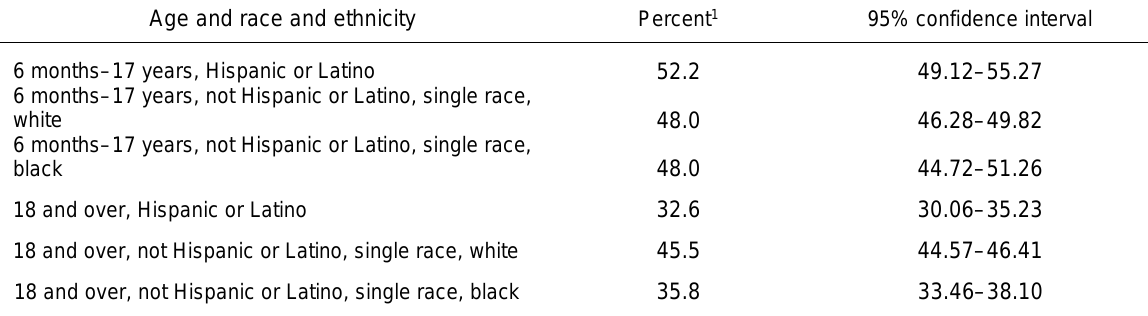
Data table for Figure 4.3. Percentage of persons aged 6 months and over